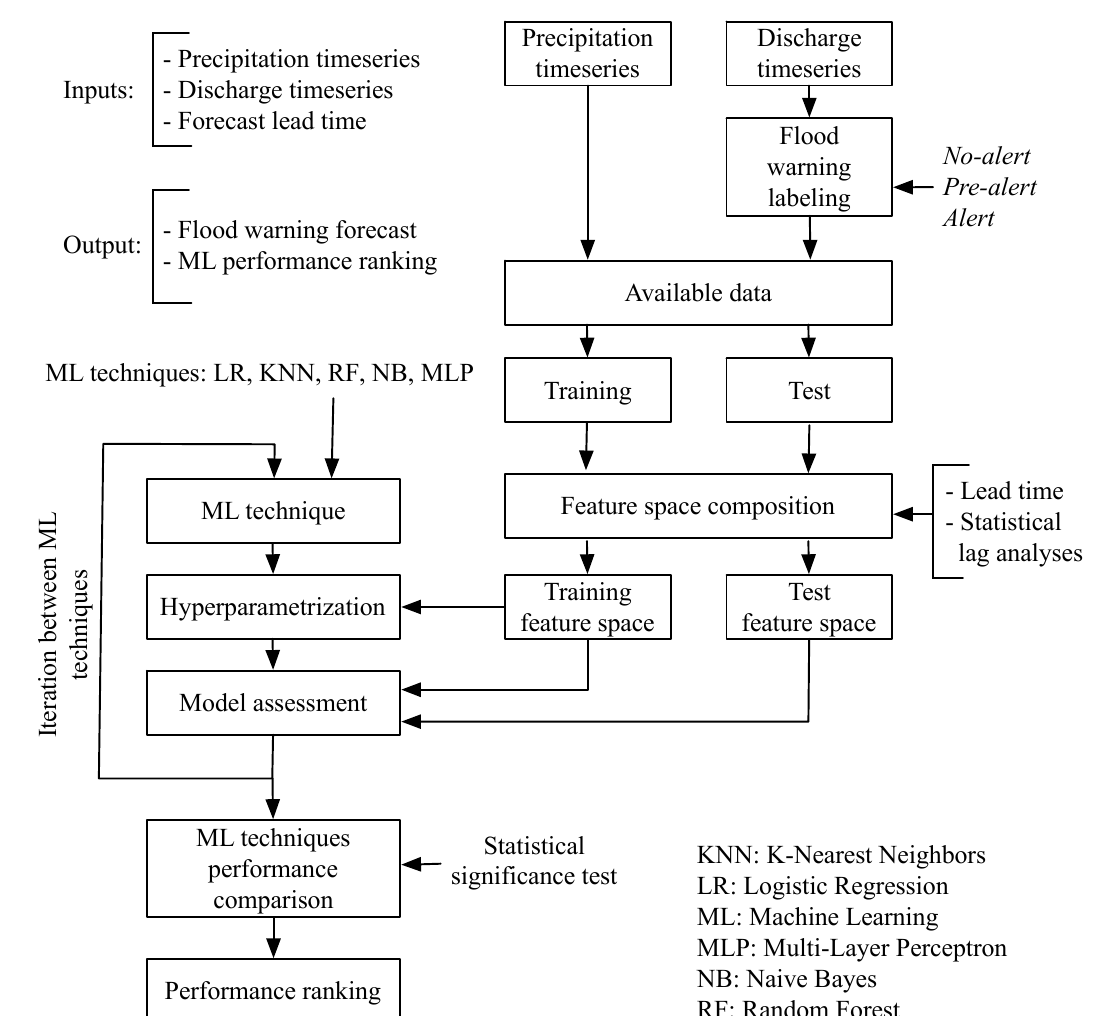
Figure 3. Work schedule for the development and evaluation of the machine learning (ML) flood forecasting models.